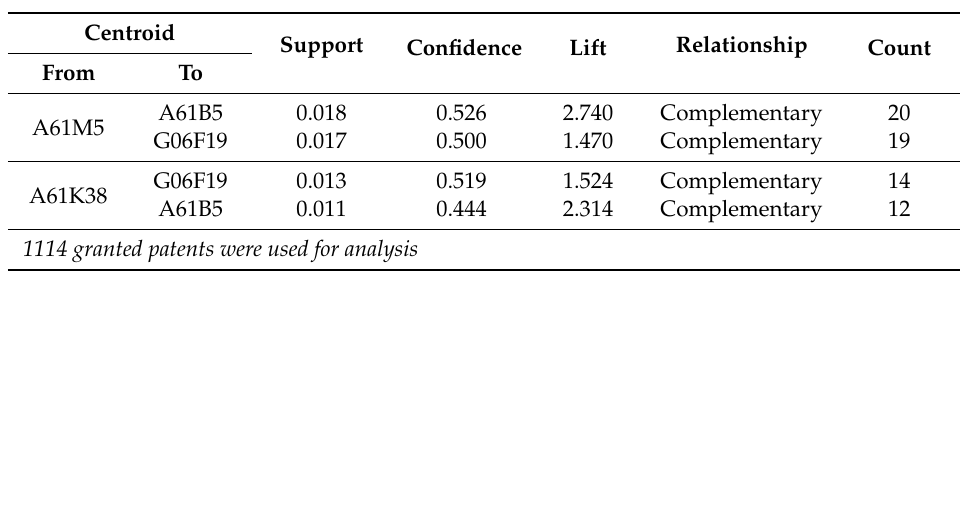
Table 6. Relationships of centroids located between clusters A61B5 and G06F19 in the data science-based pharmaceutical innovation period (2008–2015)